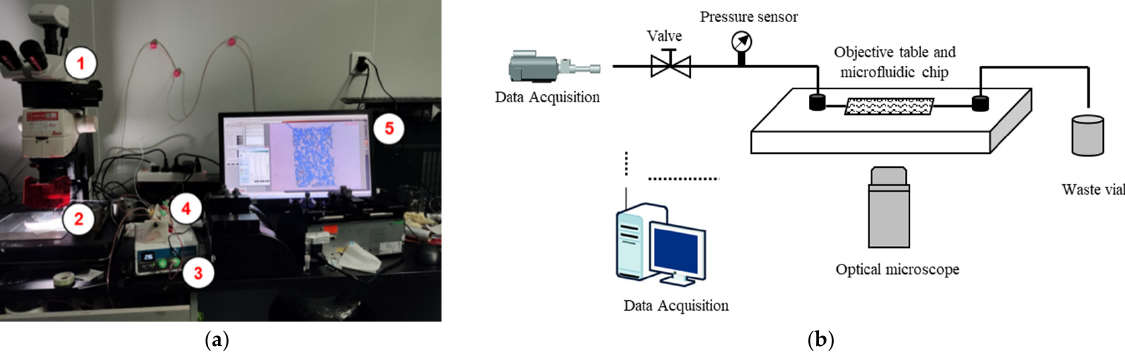
Figure 4. Microfluidic experimental equipment. ( a ) Picture of equipment; ( b ) Equipment diagram .